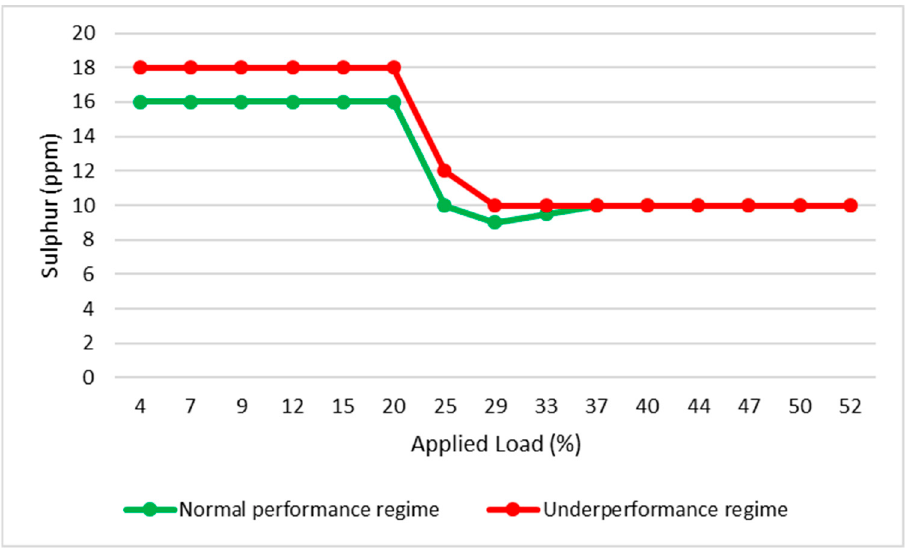
Figure 7. Variation of the S content in the exhaust gas according to the applied